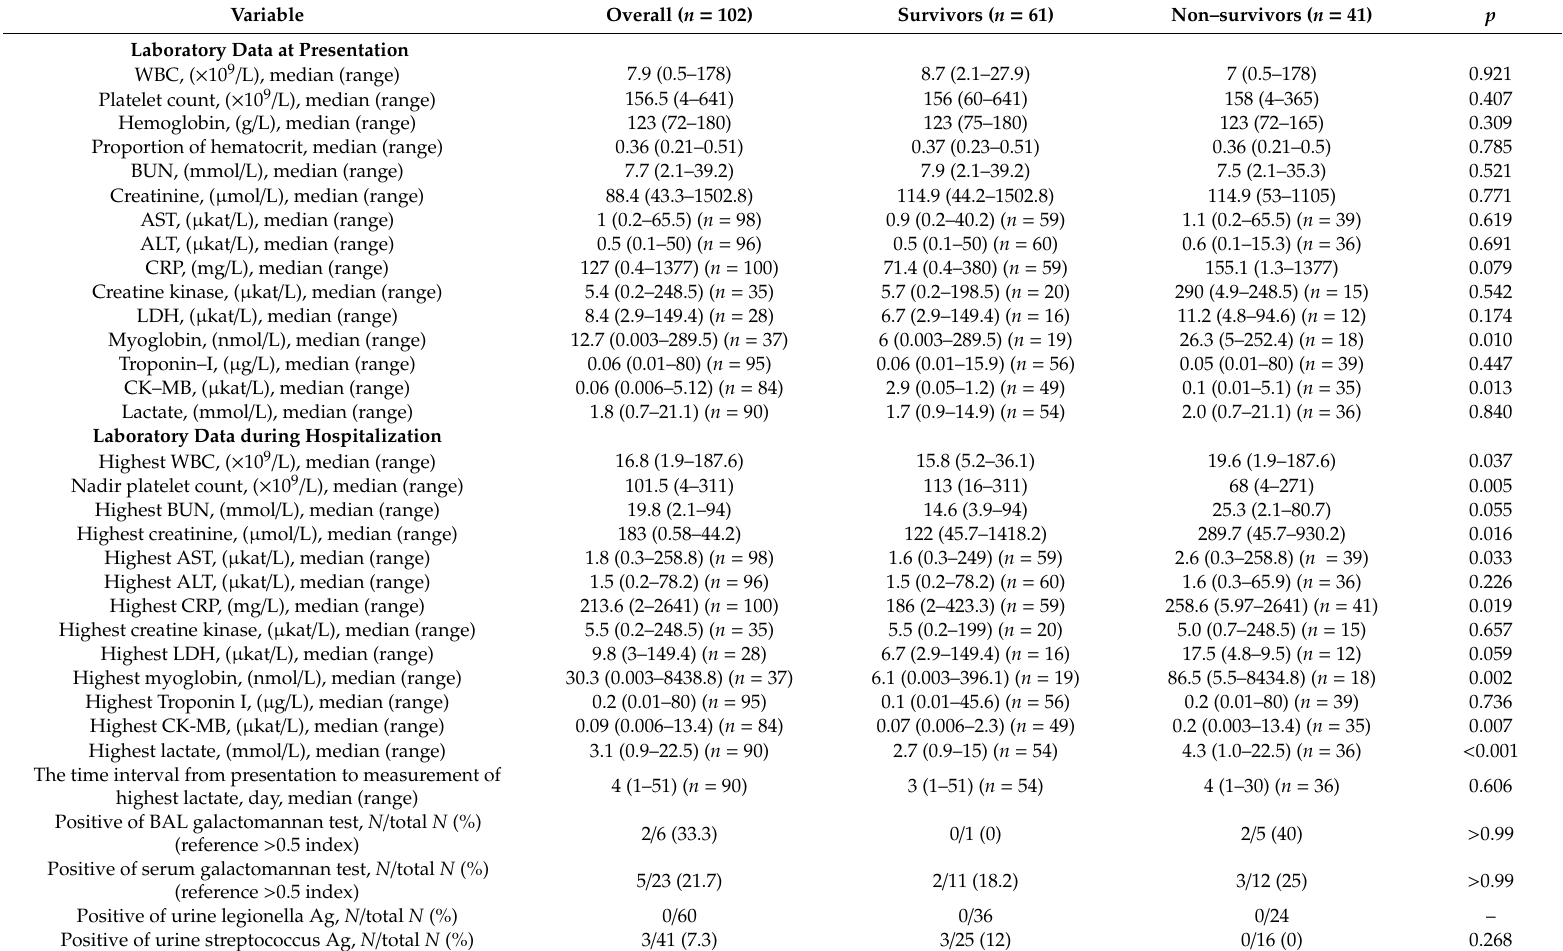
Table 3. Laboratory characteristics of patients with severe